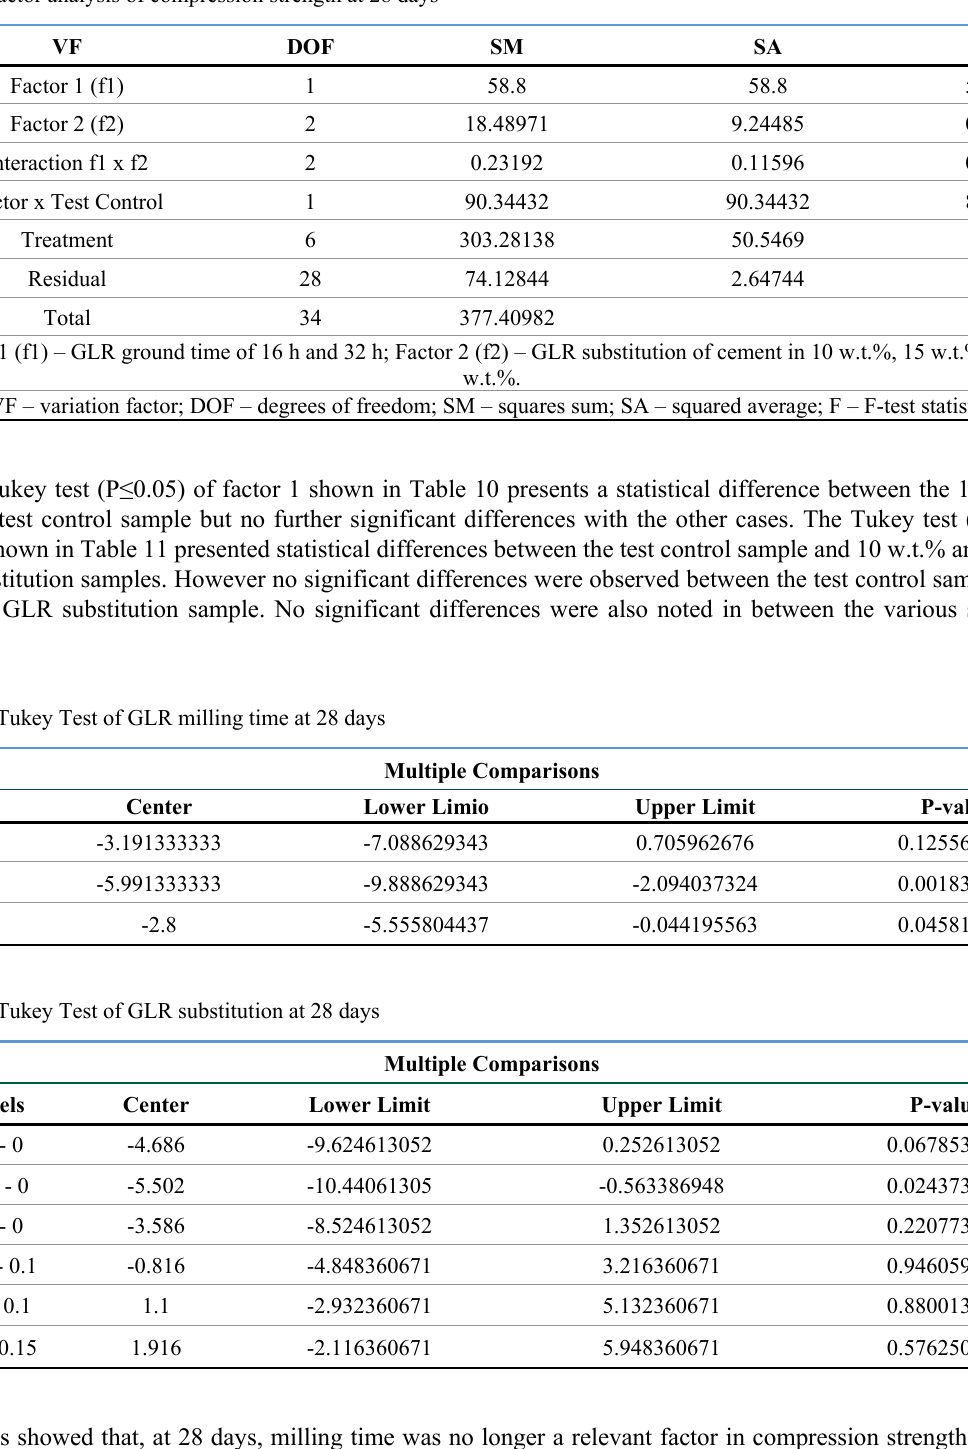
Table 9. Factor analysis of compression strength at 28 days